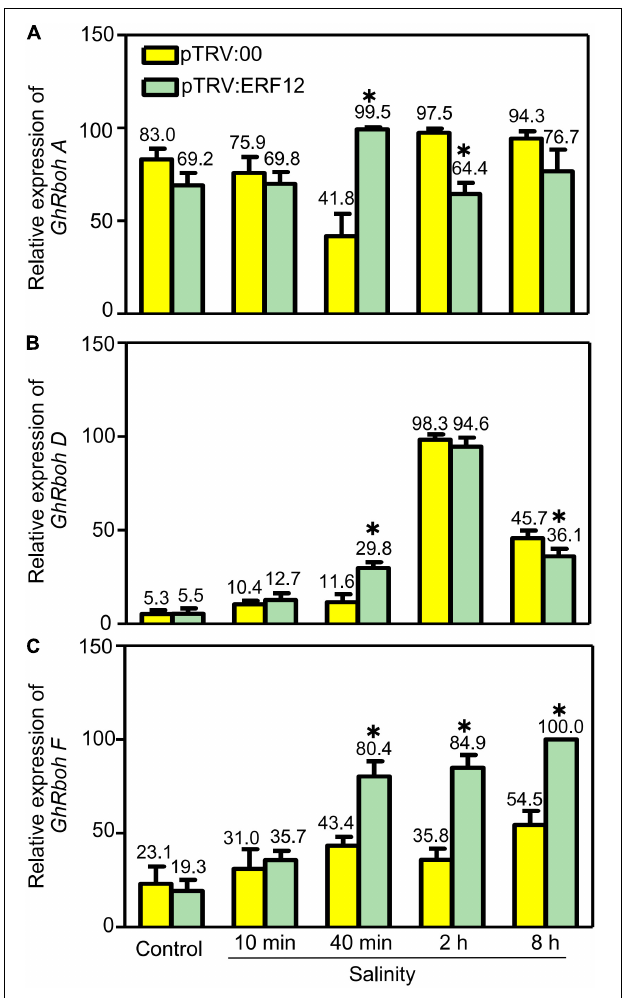
FIGURE 7 | Relative abundance of GhRboh genes ( GhRboh A, D, and F ) in GhERF12 -silenced (TRV:ERF12) and control (TRV:00) plants were determined with qRT-PCR at the given time points. GhActin9 was used as an internal control. Data represent means ± SD ( n = 6) from three independent replicates. The asterisk ( ∗ ) indicate significant differences at P < 0.05 ( t -test).